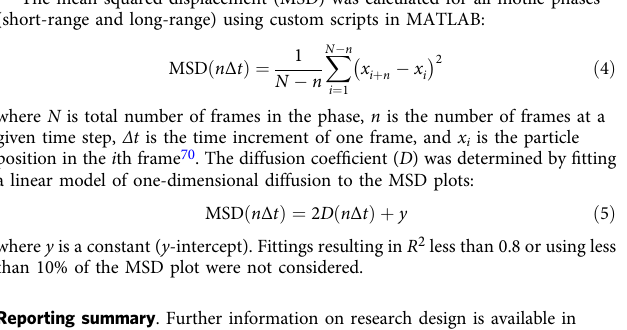
Histograms of all AFM results were plotted and Gaussians were fi t to the data by nonlinear regression in GraphPad Prism. The number of histogram bins corresponds to the square root of the sample